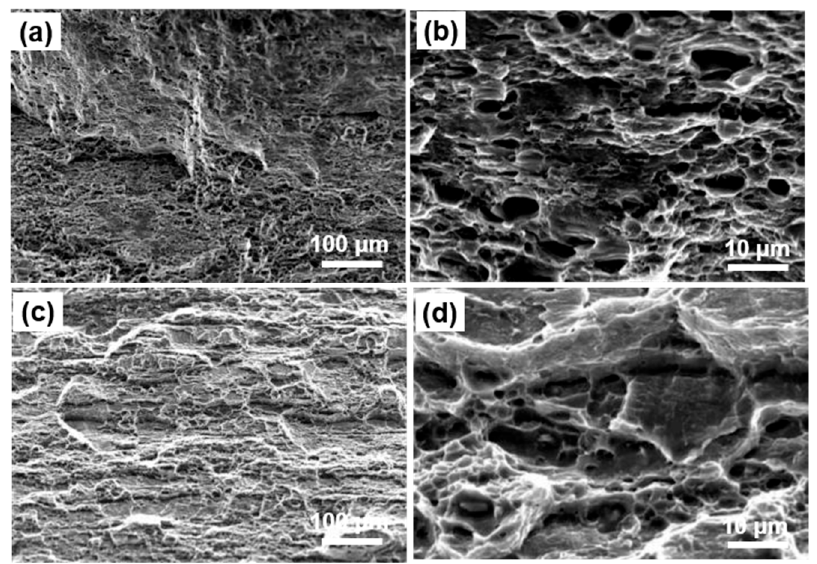
Figure 9. SEM fractography of Al-Cu-Li-Mg-Zr alloys in high growth rate regime. The micrographs collected at ( a , c ) a lower magnification and ( b , d ) a higher magnification for ( a , b ) High Fe and ( c , d ) Low Fe alloys.